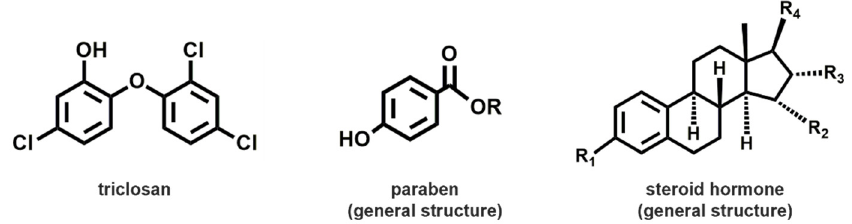
Figure 11. Chemical structures of triclosan, parabens and steroid